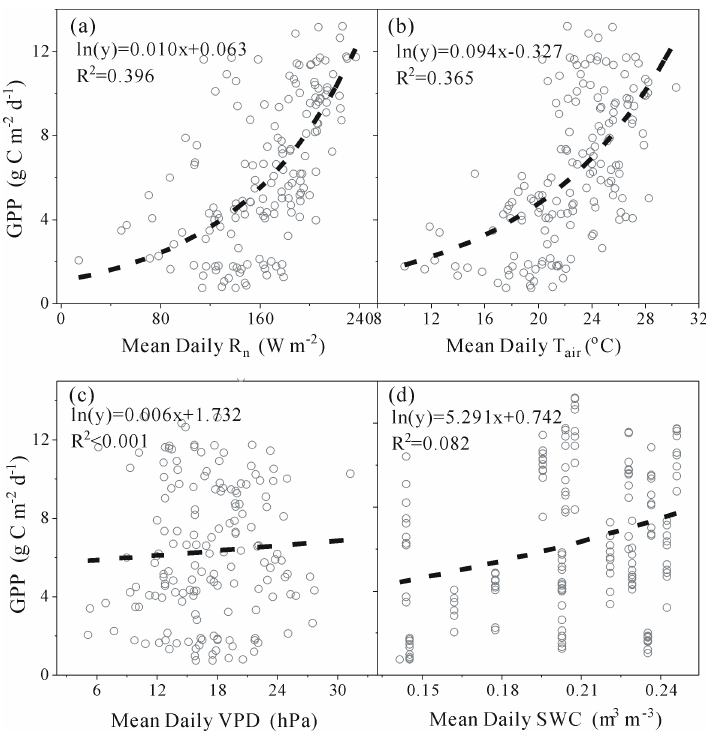
Fig 6. The relationship between total daily GPP (gross primary production) and mean daily R n (net solar radiation), T air (air temperature), VPD (vapor pressure deficit) and SWC (soil water content), respectively.